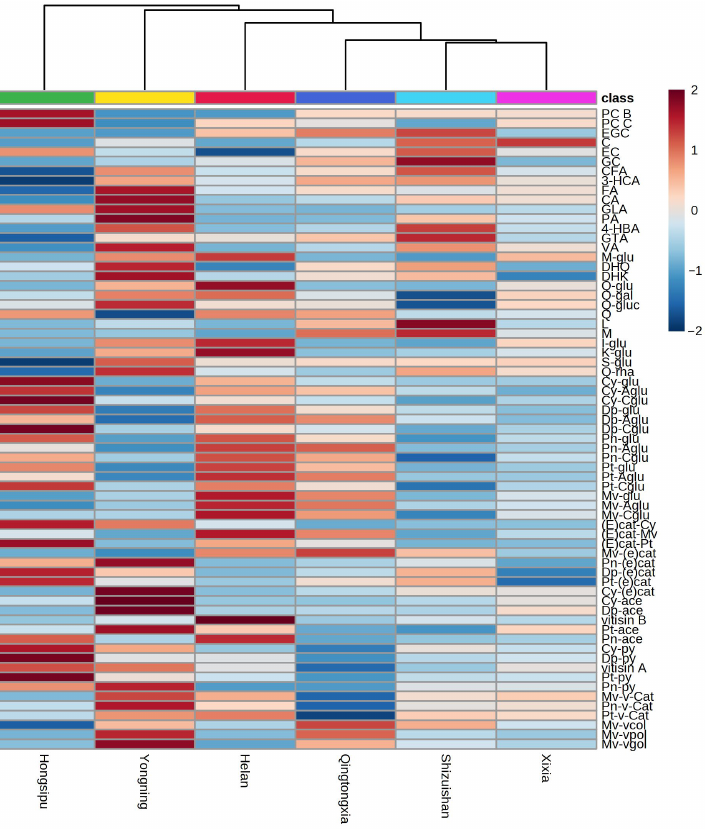
Figure 3. Hierarchical cluster analysis based on the concentrations of phenolic compounds in Cabernet Sauvignon wines in the six sub-regions of EFHM.